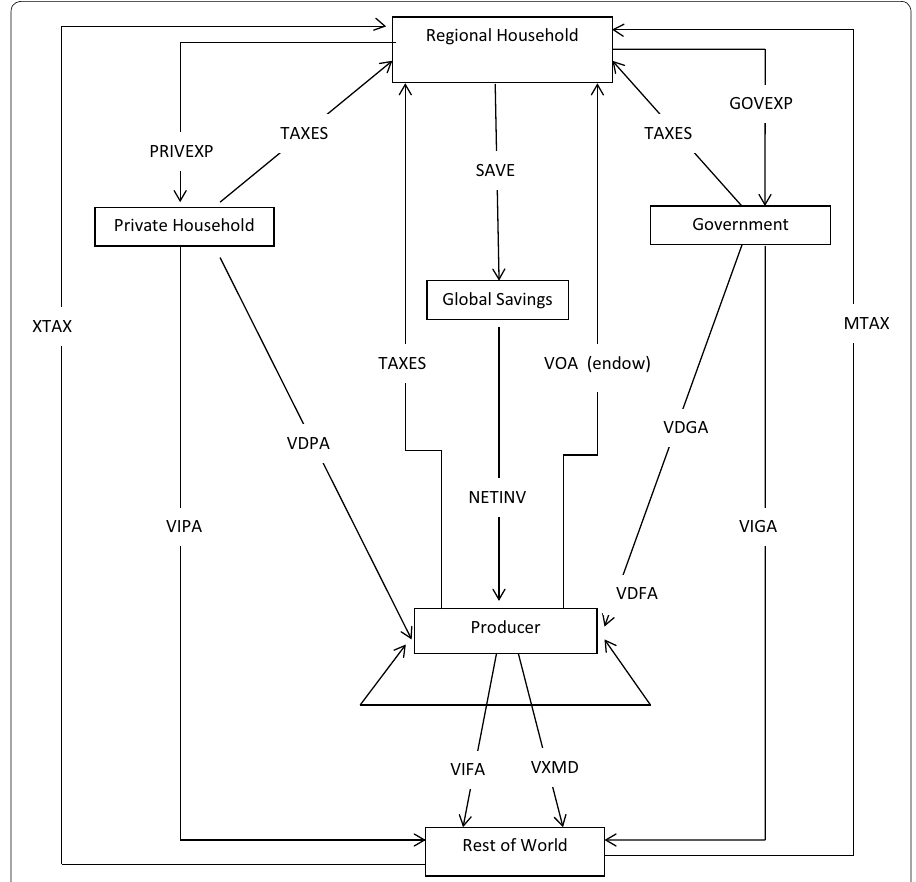
Fig. 5 A graphical exposition of the GTAP model. Source : Brockemeier,